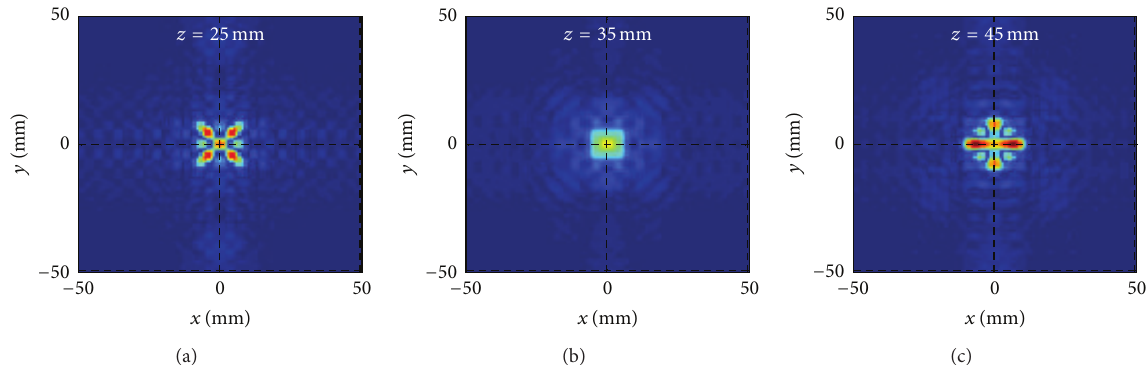
Figure11:Reconstructedimages(shownevery10 mmalong 𝑧 andonlyatthreerangelocations)whenthedistancebetweenthereconstruction planes is Δ𝑧 = 5 mm for the example in Figure 6(d). Color bars are the same as those in Figure